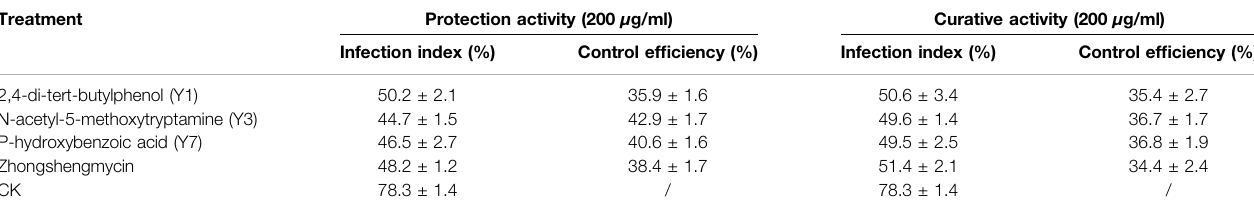
TABLE 3 | Protective activity of 2,4-di-tert-butylphenol, N-acetyl-5-methoxytryptamine, P-hydroxybenzoic acid, and zhongshengmycin against BLB at different concentrations (greenhouse conditions).